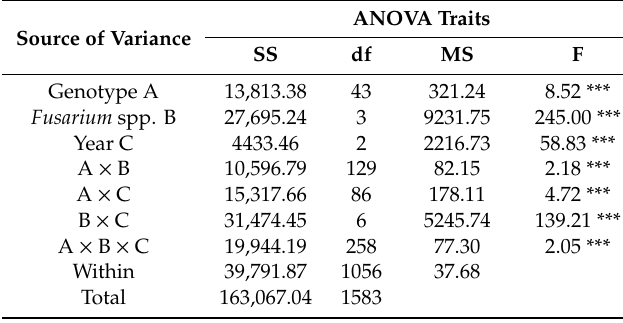
Figure 6. Resistance of hybrid Beym against different Fusarium spp. Toothpick method, kernel resistance. ( Left upper ): F . graminearum , ( right upper ): F. culmorum , ( left lower ): F. verticillioides , ( right lower ): naturally infected control. Table 3. Kernel resistance, ANOVA from the data of Table